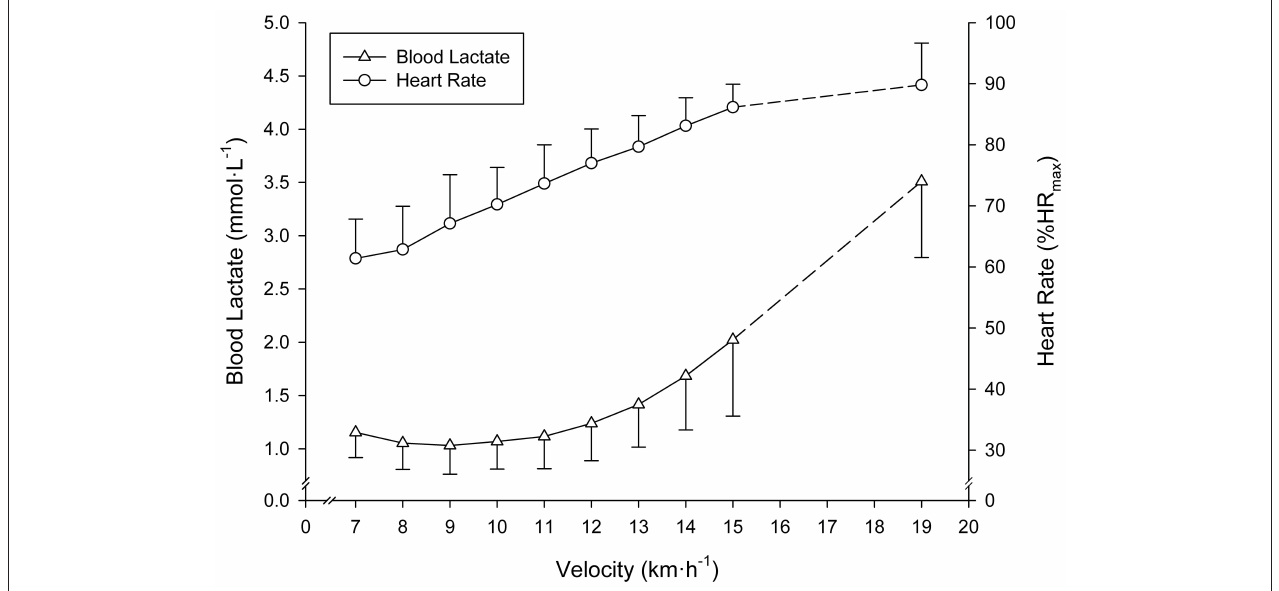
FIGURE 2 | Mean (SD) blood lactate and heart rate responses to the submaximal discontinuous incremental running exercise test. All subjects terminated the 15 km · h − 1 exercise stage. Mean (SD) values at completion of the test of subjects achieving ≥ 16 km · h − 1 are indicated by dashed lines.